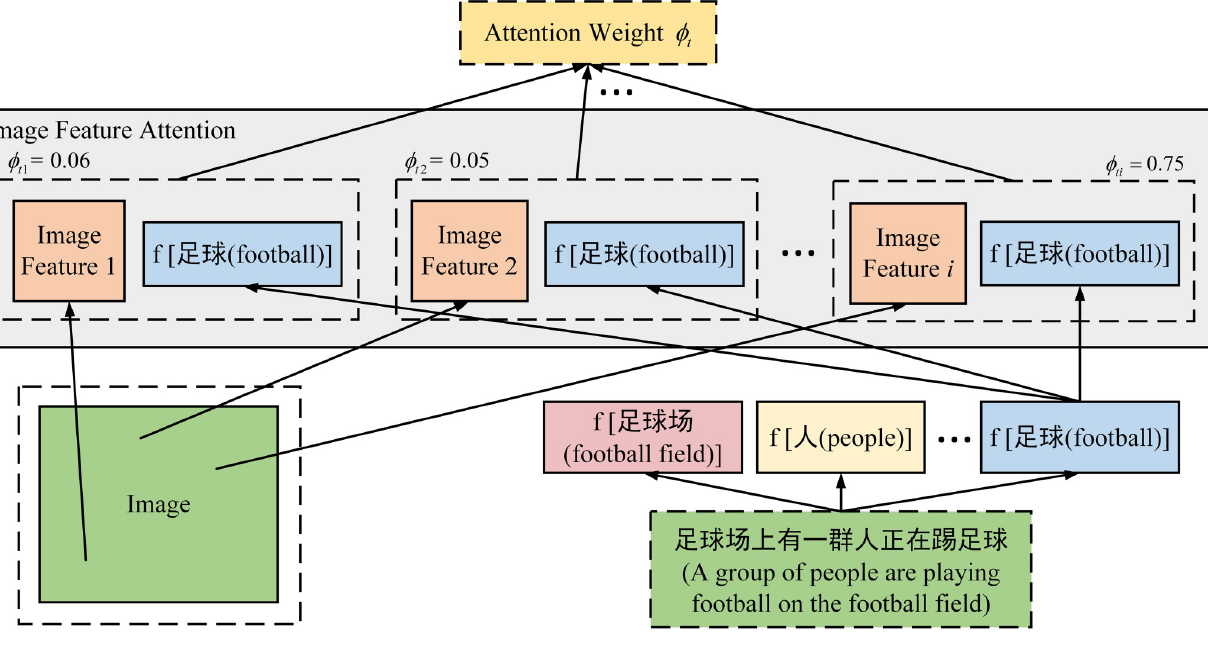
Fig 4. Attention weight of image